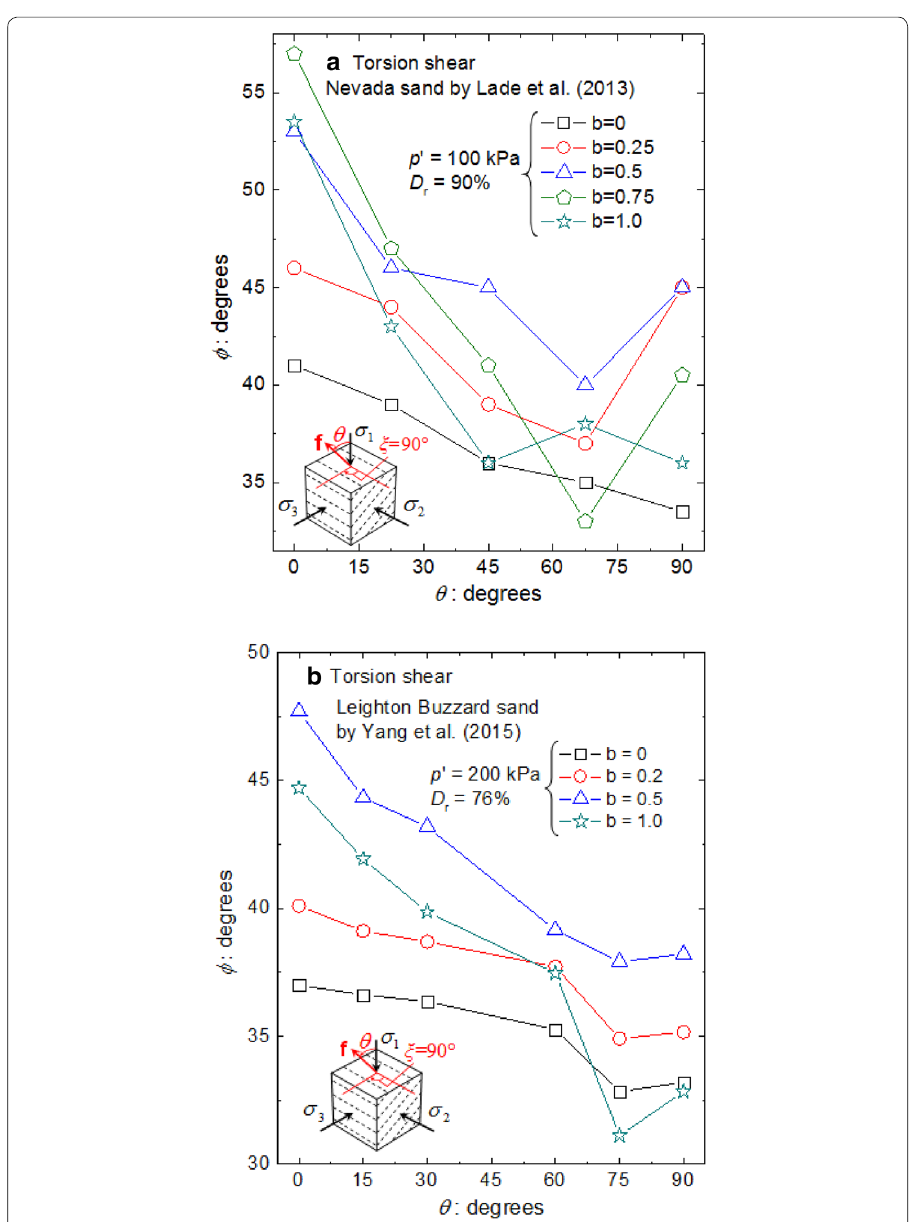
Fig. 3 Anisotropic strength of Nevada sand and Leighton Buzzard sand in torsion shear